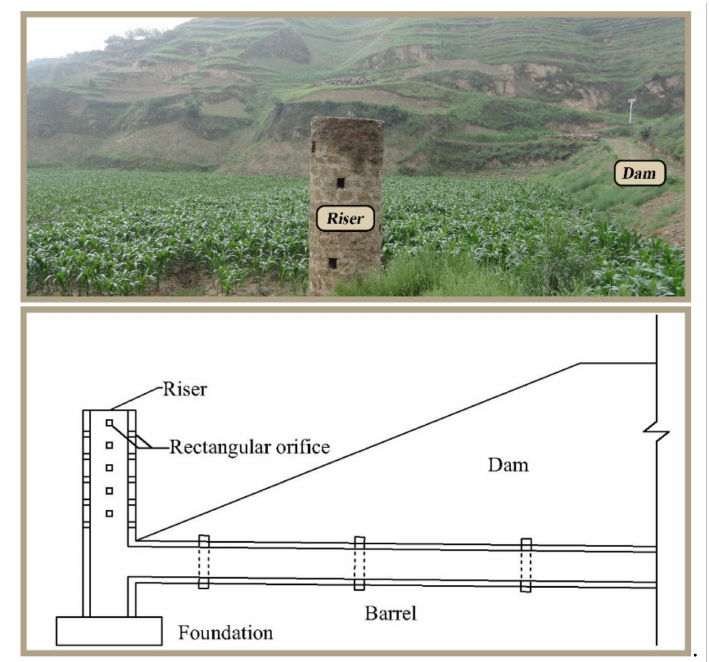
Figure 4. On-site photo and sketch of perforated riser principal